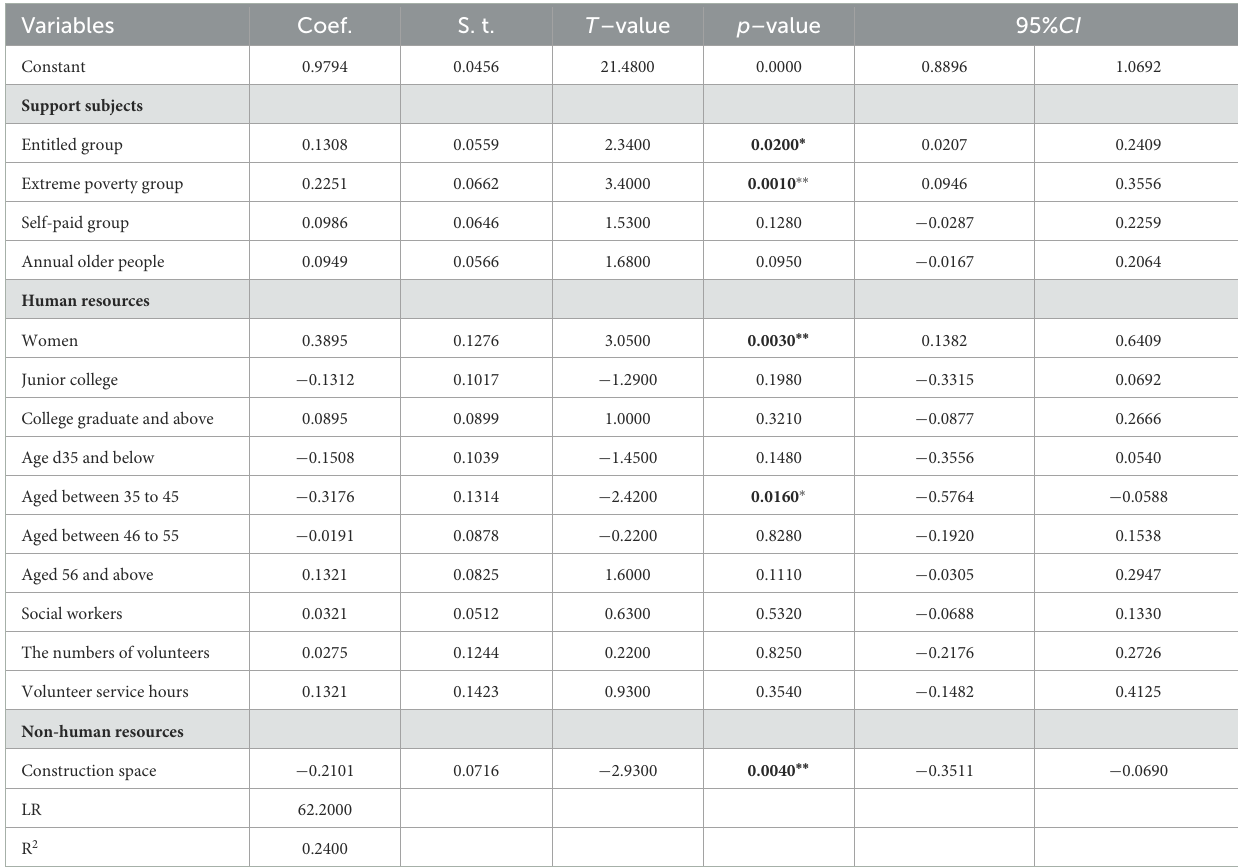
TABLE 6 Tobit regression analysis of the influential factors of LTCFs